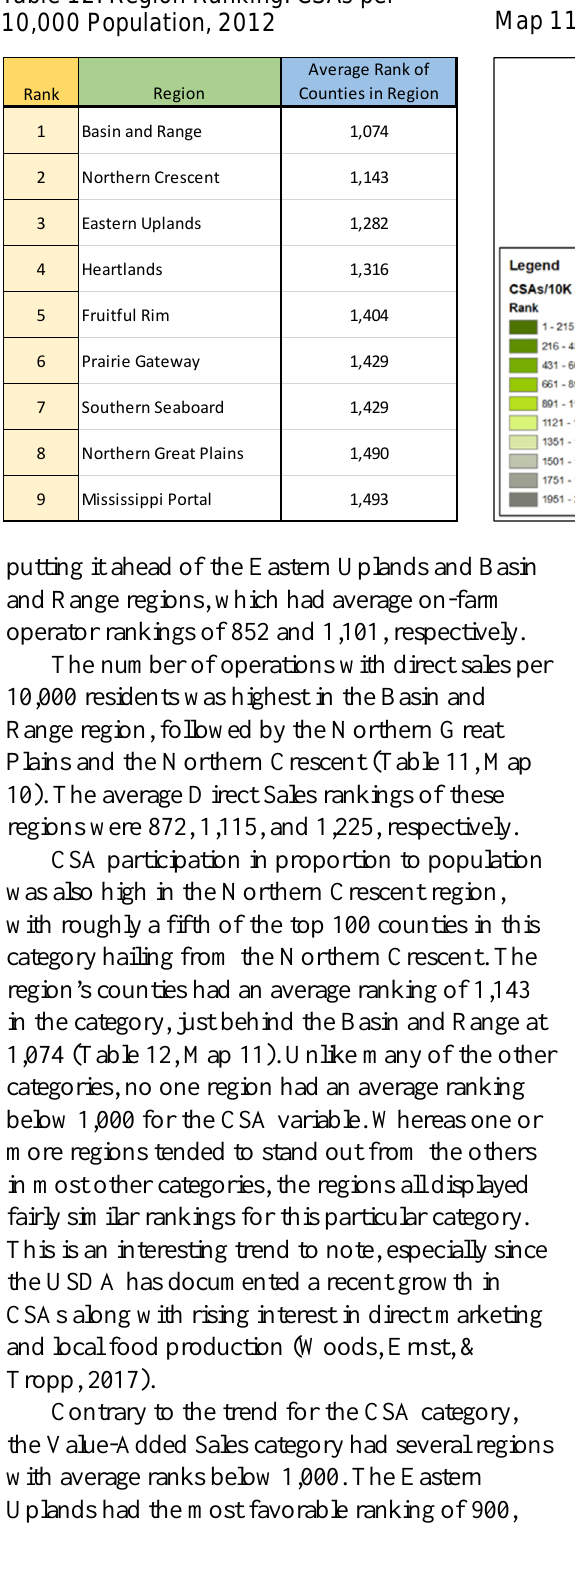
Table 12. Region Ranking: CSAs